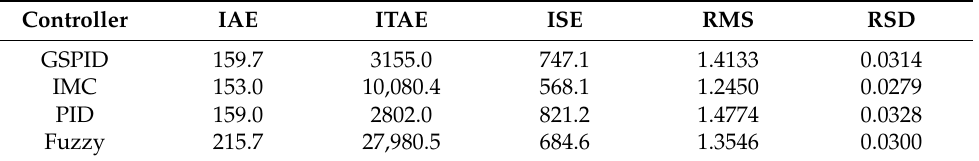
Table 7. Performance indexes obtained considering a 400 s simulation time.